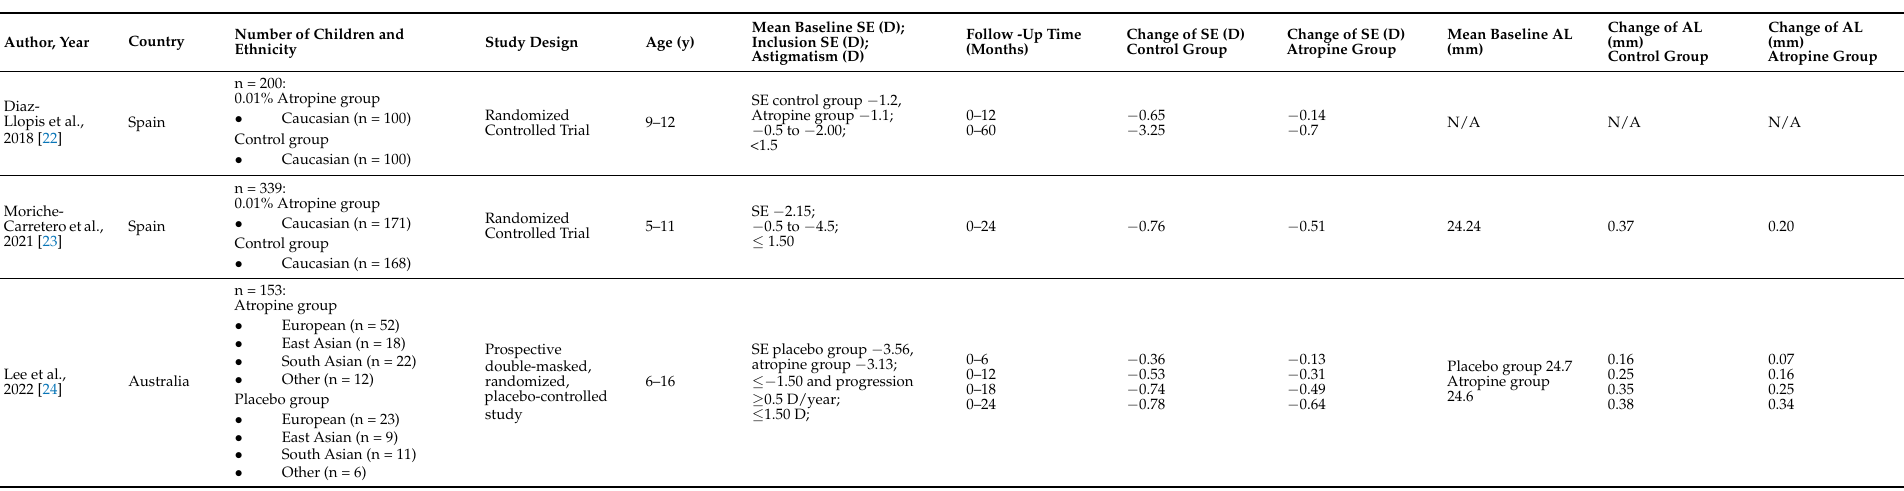
Table 2. Characteristics of RCTs included in the